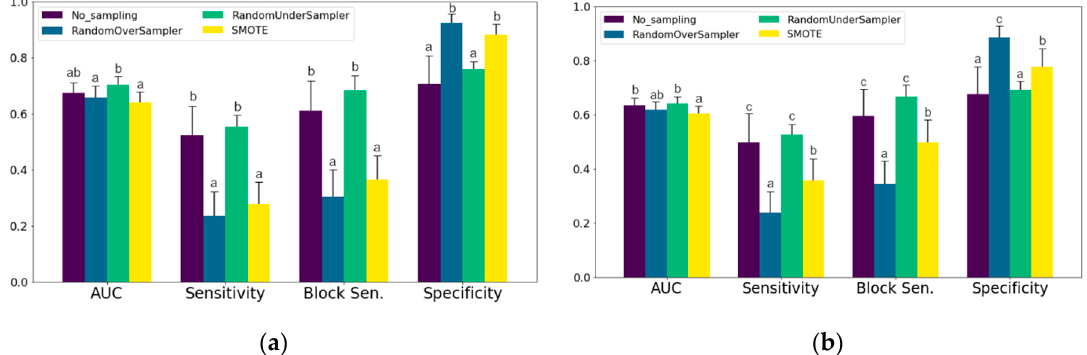
Figure 2. Mean test data AUC, Sensitivity, Block Sensitivity and Specificity ( ± 95%-CI) for each sampling method. ( a ) Mastitis treatments; ( b ) Lameness treatments. Different letters indicate significant ( p < 0.05) differences between sampling methods. AUC: Area Under ROC-Curve; SMOTE: Synthetic Minority Over-sampling Technique.